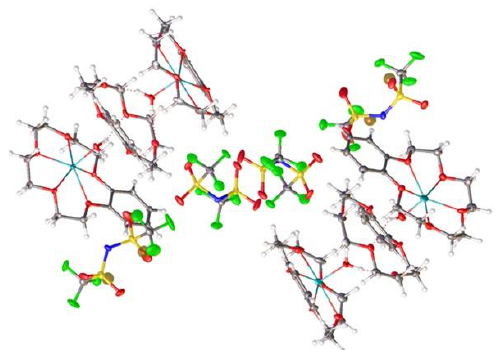
Figure 9. Structure of components of crystal unit cell in (II tr ) . Ellipsoids of atomic l.s. thermal displacements are given at the 50% probability level.